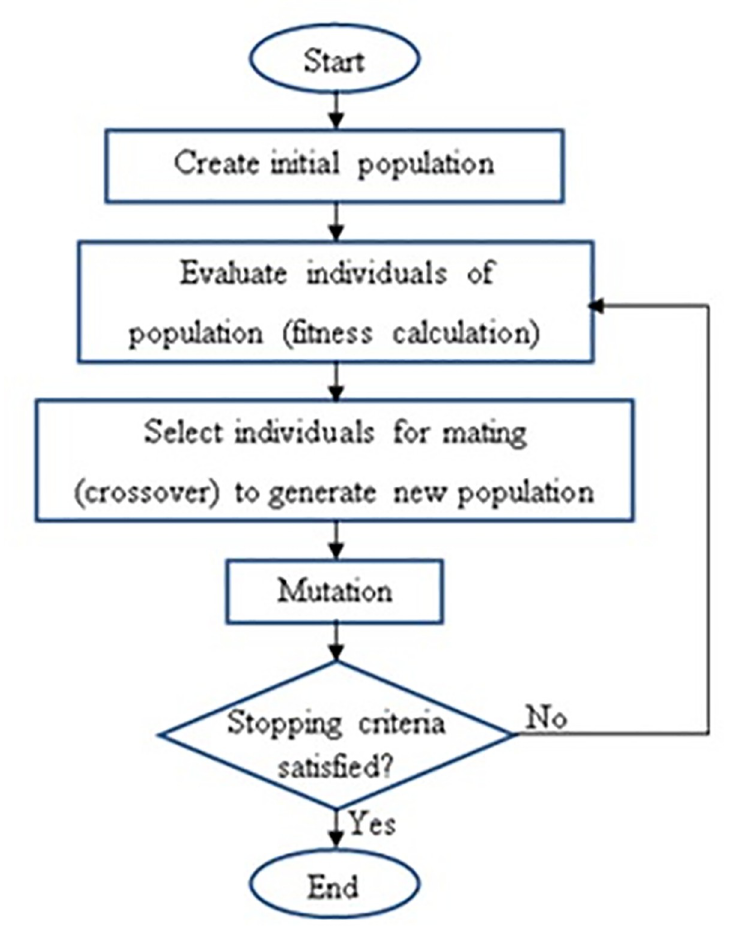
Fig 2. Main idea of Genetic Algorithm (GA)